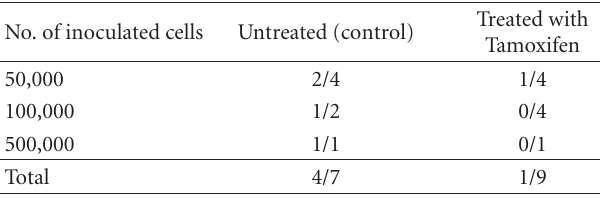
Table 1: Number of positive outgrowths from mammary glands divested of epithelium and inoculated with various amounts of untreated or Tamoxifen-treated Itg β 1 fx / fx , CreER Cells.